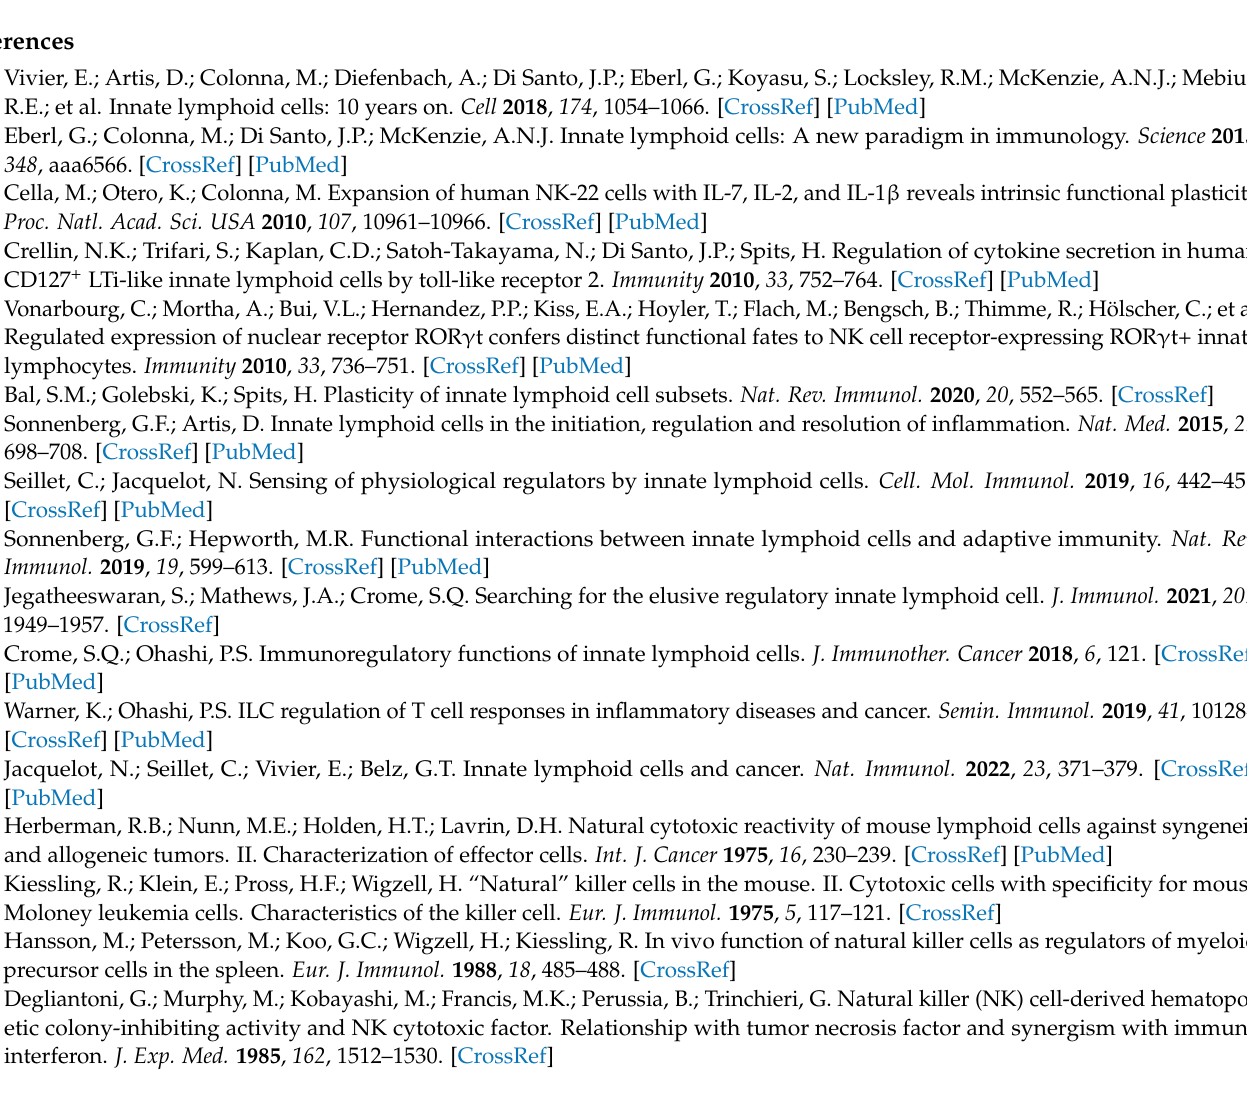
figure design, N.J.; writing—reviewing and editing, D.C.C., M.G., K.W., N.J., and P.S.O.;